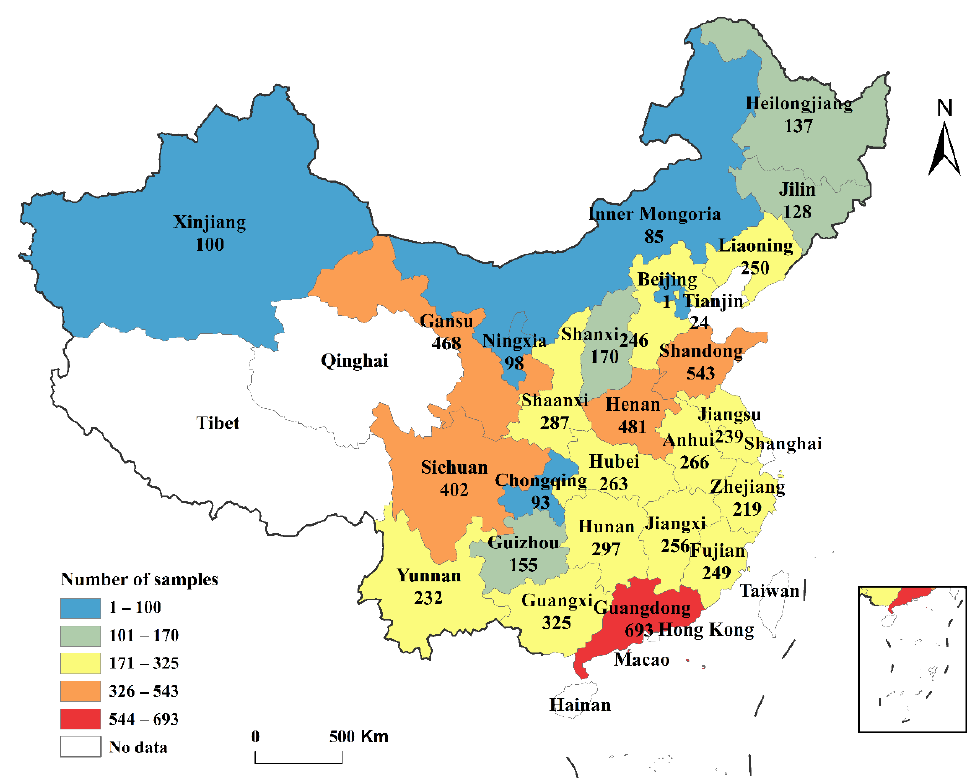
Figure 1. Spatial distribution of sample households.